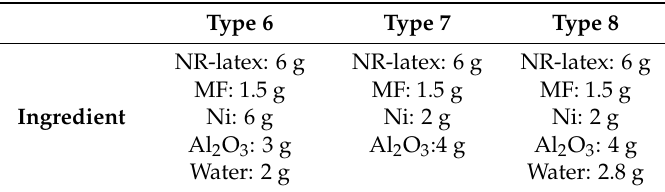
Table 4. Ingredient combinations of MCF rubber liquids Types 6–8 with dielectric